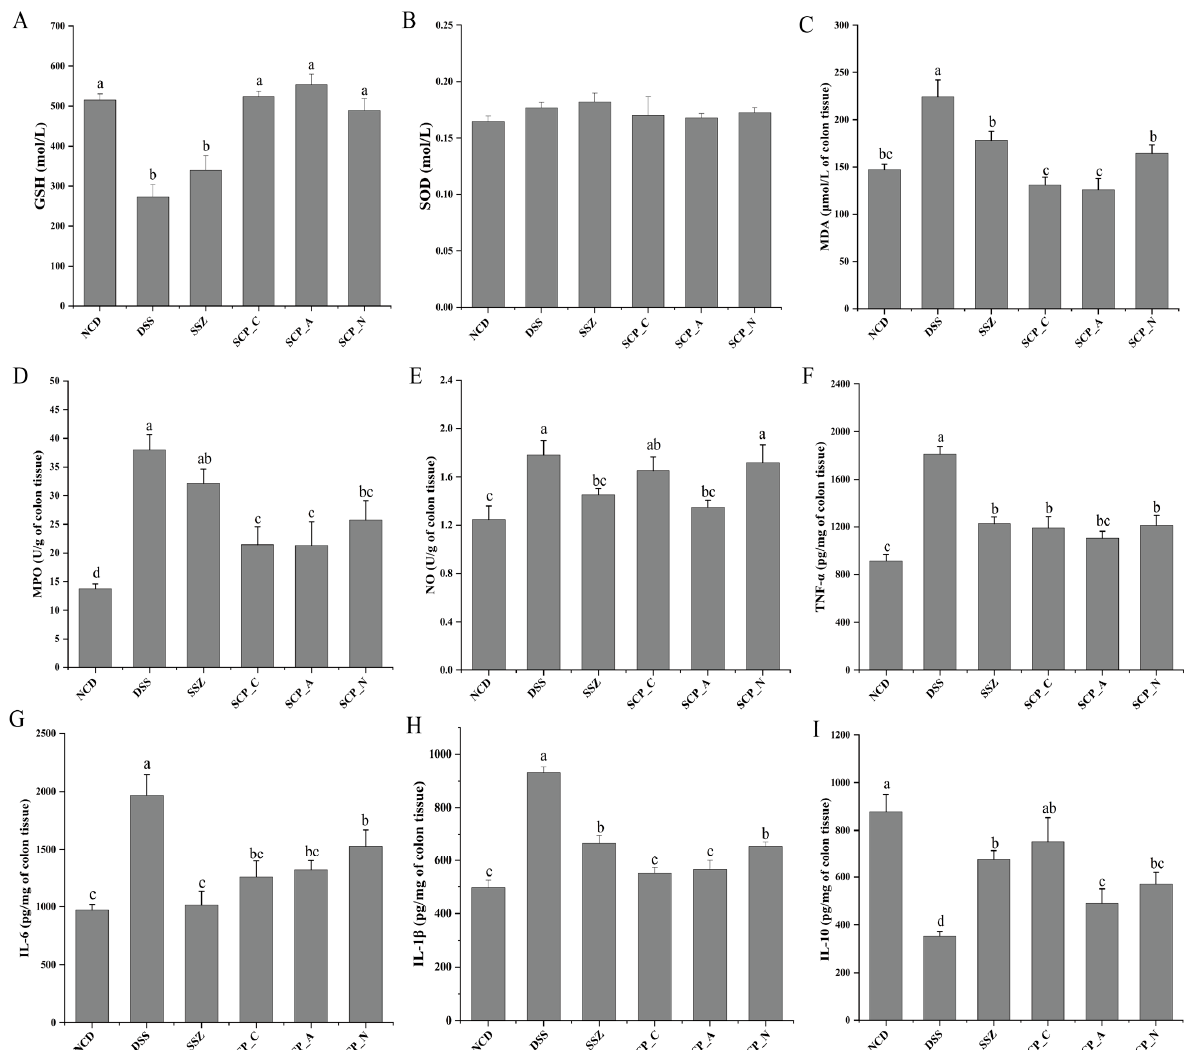
Figure 3. Effect of polysaccharide treatment on oxidative stress and inflammatory cytokines. ( A ) GSH and ( B ) SOD in serum; the levels of ( C ) MDA, ( D ) MPO, ( E ) NO, ( F ) TNF- α , ( G ) IL-6, ( H ) IL-1 β , and ( I ) IL-10 in colon tissues. Different letters (a, b, c) represent significant differences among groups ( p < 0.05).